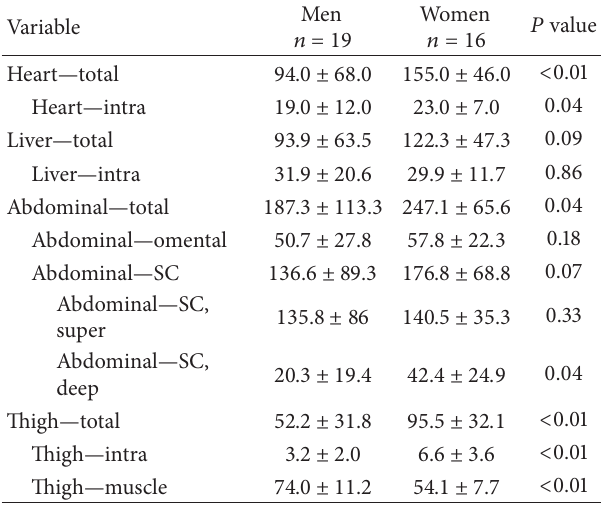
Table 2: Regional fat characteristics measured by CT